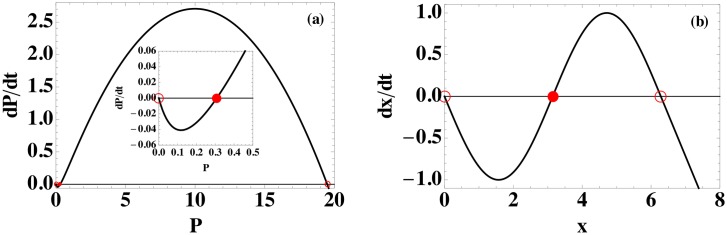
Comparison of ODE models (5) and (6).The functions f(P) = dP/dt and f(x) = dx/dt for models (a) (5) and (b) (6). (See Eqs (17) and (18)). Stable and unstable fixed points are marked by open and filled circles, respectively. Both models share the same fixed point topology: one stable fixed point at zero and one at a positive value. The unstable fixed point lies between the two stable fixed points. The inset in (a) magnifies dP/dt near the origin.